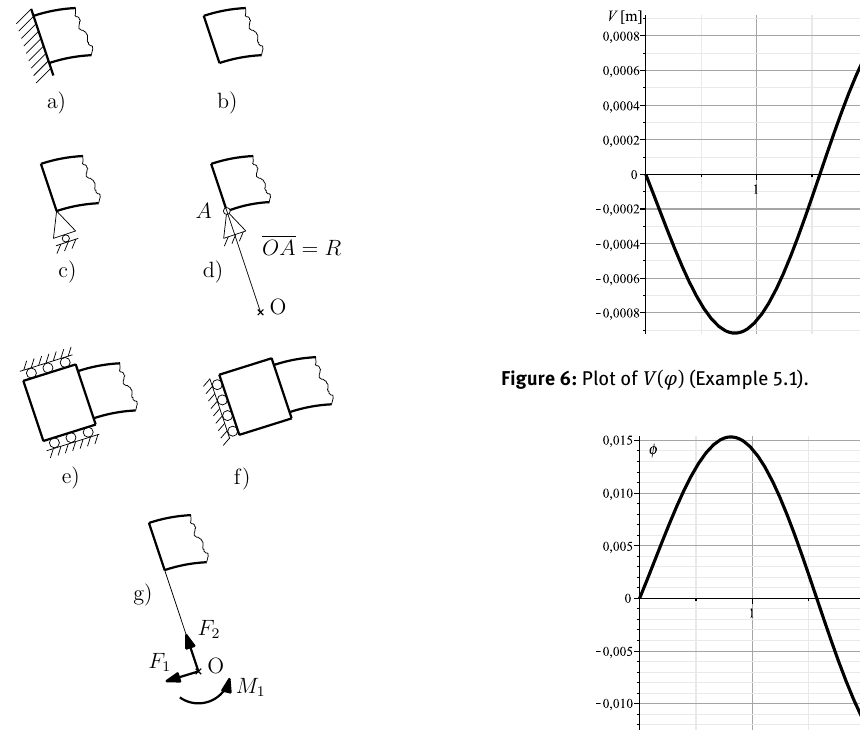
Figure 3: In-plane boundary conditions for two-layer composite